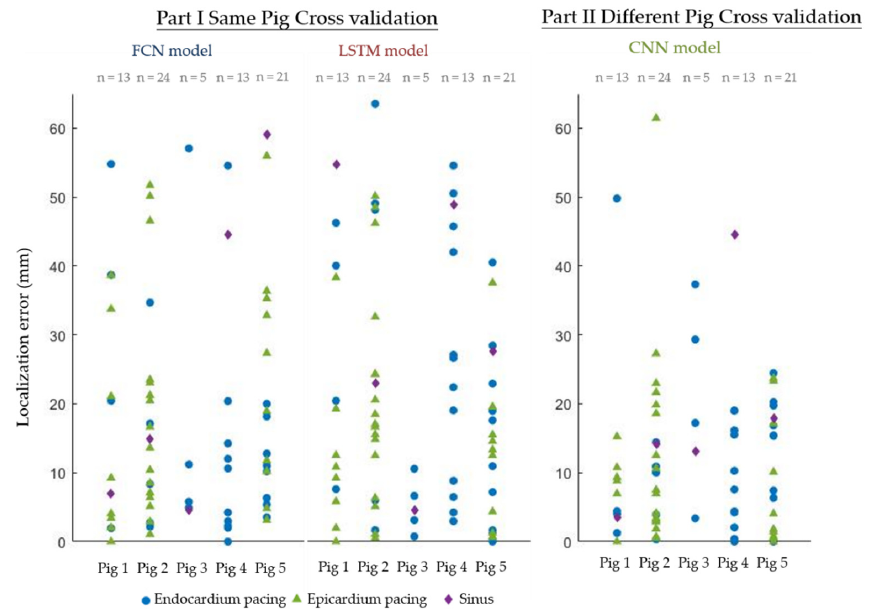
Figure 15. Localization error. ( Left ): Localization error of cross-validation of the data from the same pig. ( Right ): Localization error of cross-validation with different pigs.